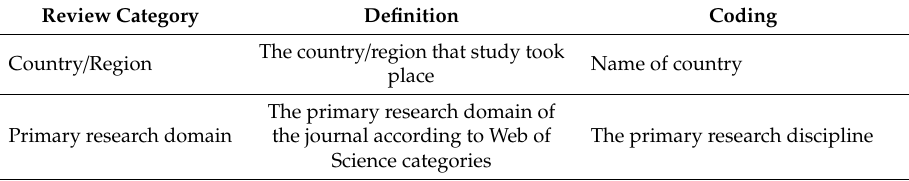
Table 1. The selected review categories for the papers with their definition and